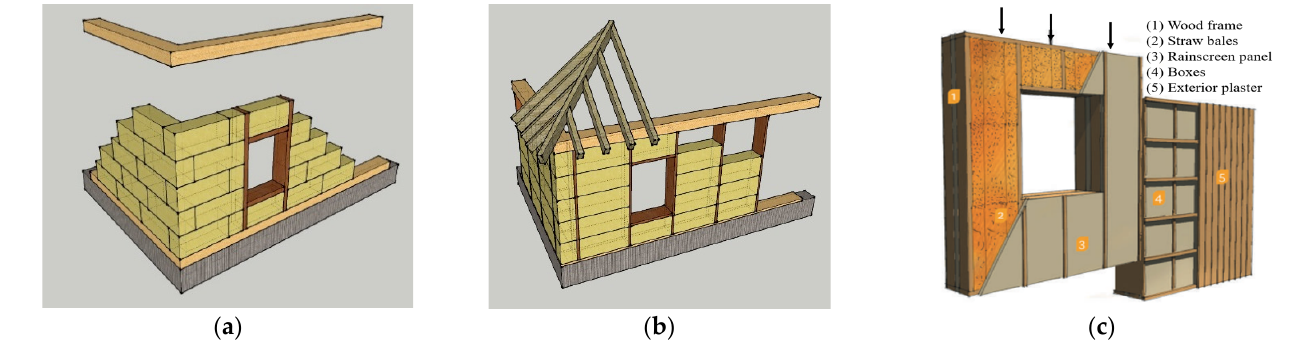
Figure 4. ( a ) Load-bearing, ( b ) nonstructural, and ( c ) prefabricated straw building construction techniques (based on [28,59]).